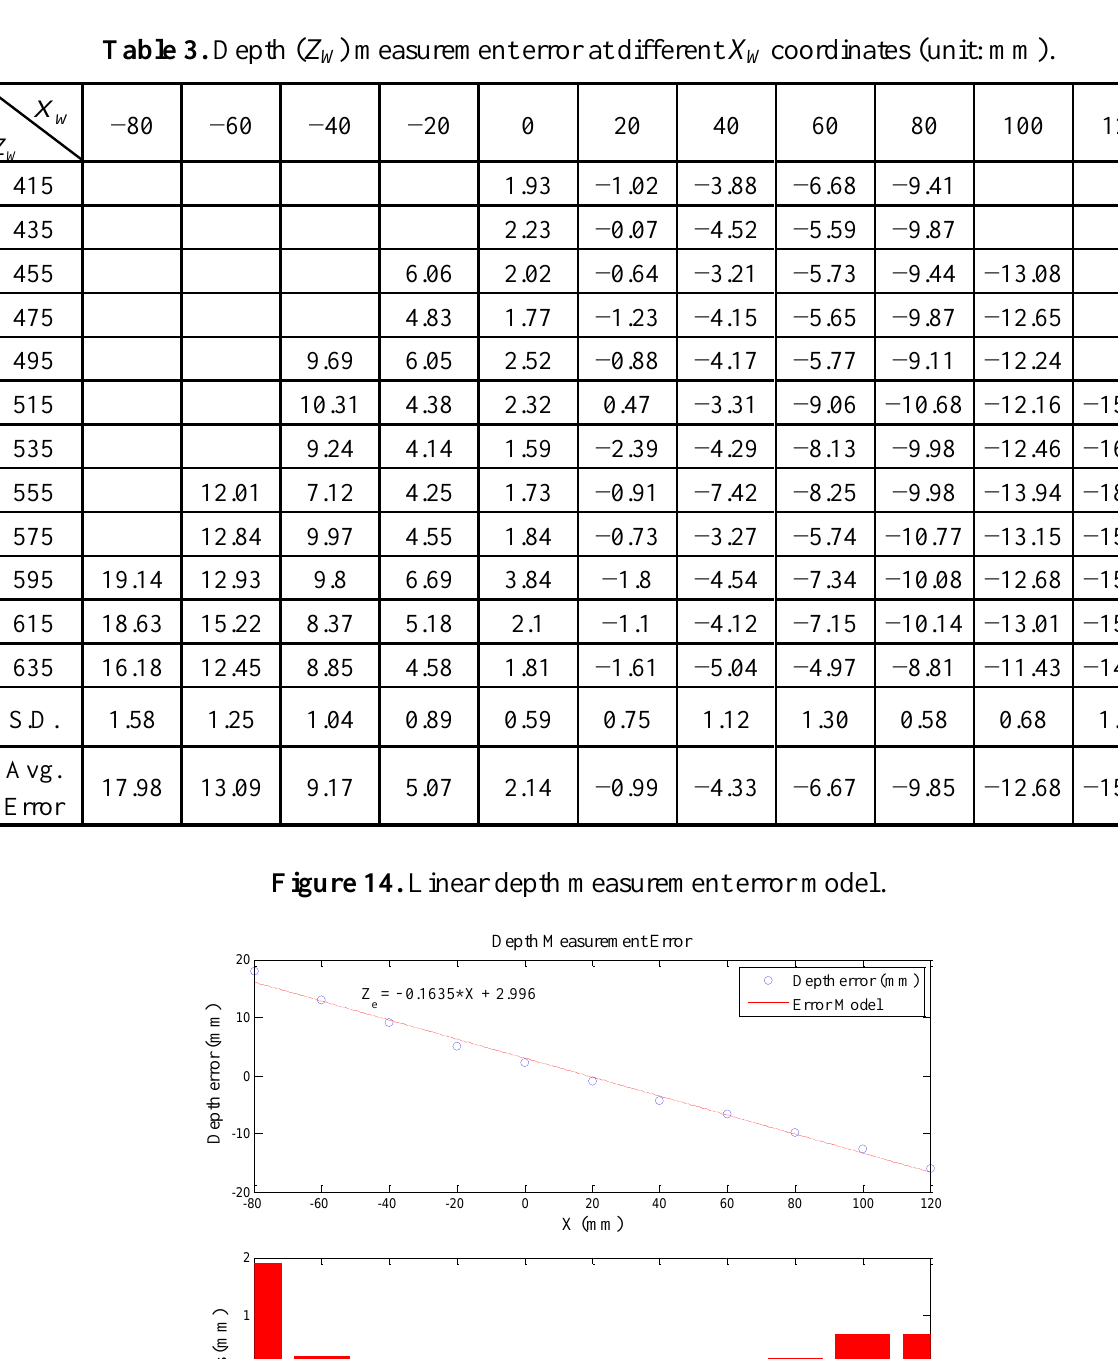
Table 3. Depth ( Z